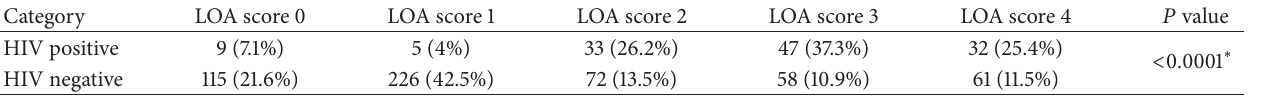
Table 5: LOA scores (loss of attachment) between HIV positive and negative